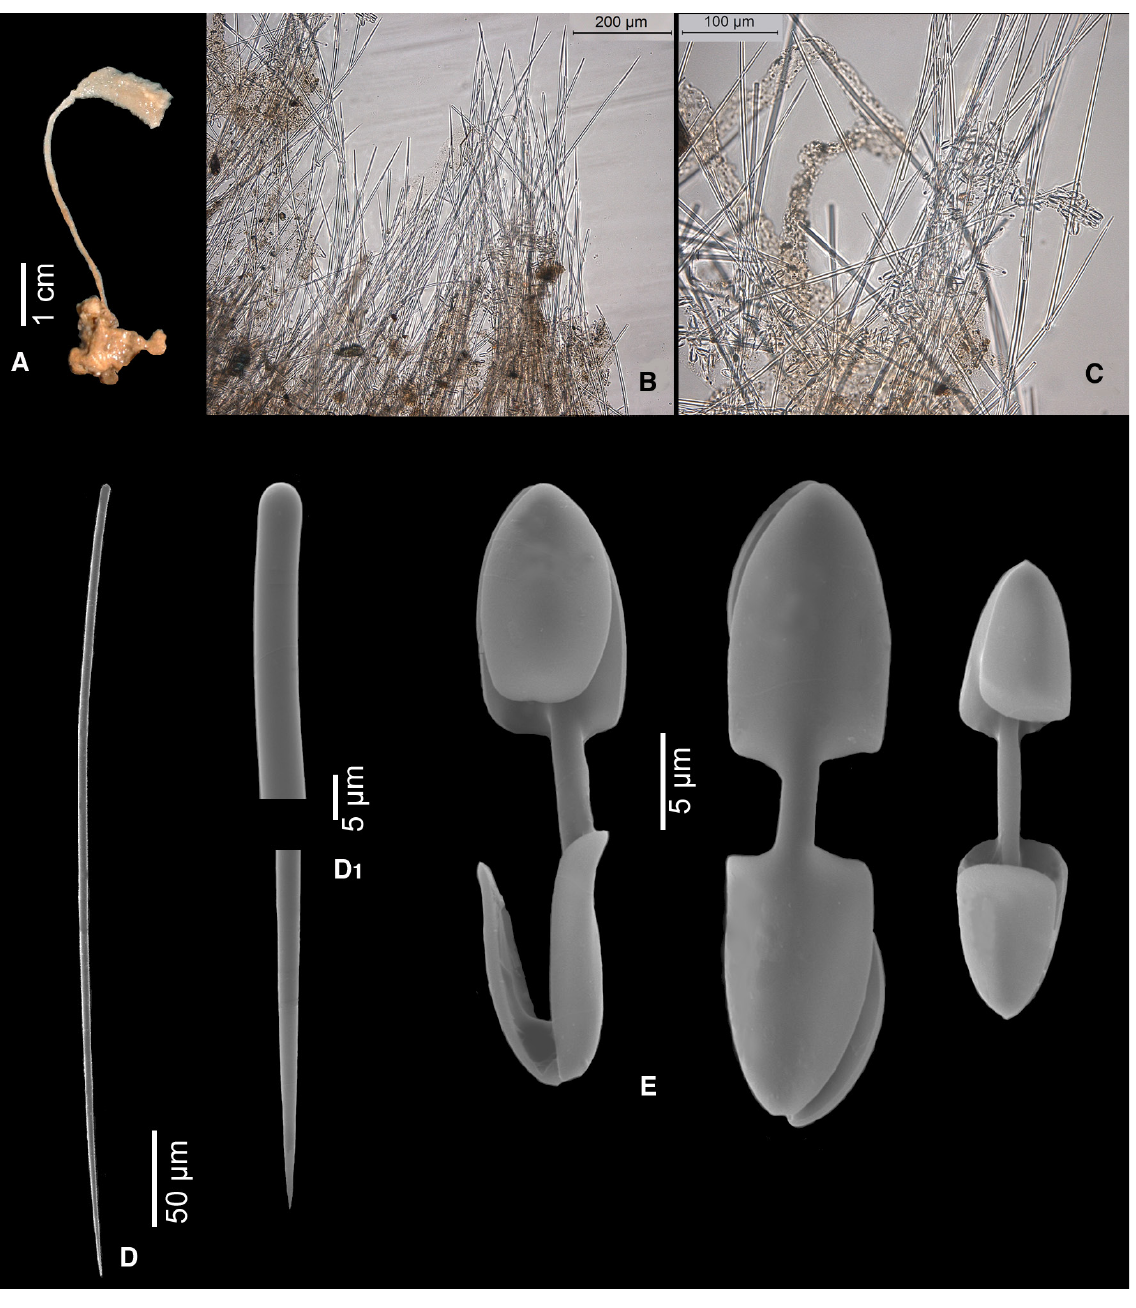
Fig. 4. Amphilectus strepsichelifer sp. nov., Holotype ZMA Por. 07564. A . Habit. B-C . Cross section of skeleton in light microscopy. B . Peripheral skeleton. C . Detail of peripheral tracts and clustered microscleres. D-E . SEM images of spicules. D . Style. D various stages of